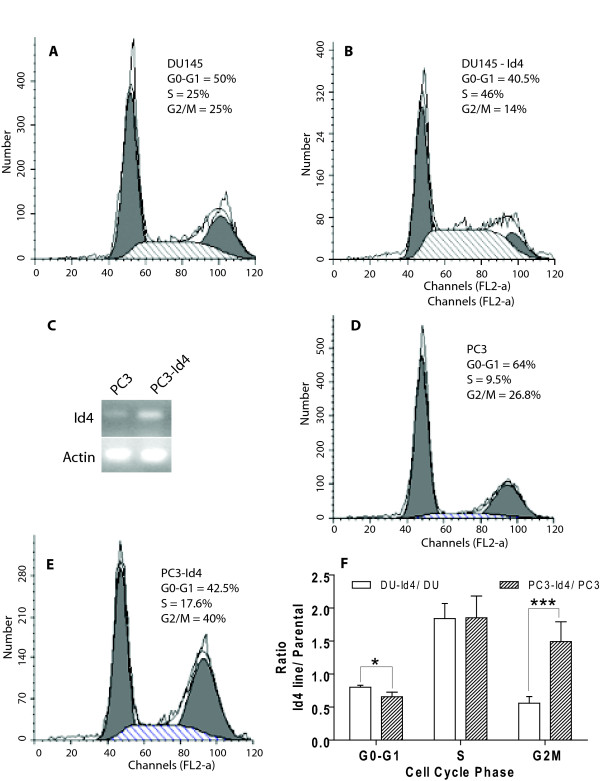
FACS analysis of cell cycle parameters in DU145, DU145-Id4, PC3 and PC3-Id4 cell lines. The cells were serum starved for 24 hours in order to synchronize the cell cycle. The cells were then serum stimulated (10% BCS) in order to determine the effect of Id4 on cell cycle. A and D: Serum treated DU145 and PC3 cells respectively, B and E: Serum treated DU145-Id4 and PC3-Id4 cells respectively. The cell cycle analysis and the fraction of cells in each phase (G0-G1, S and G2/M, indicated as % cells) were determined using ModFit cell cycle analysis software. The data is representative of triplicate experiments. Of note is the number of cells (scale) represented on the Y-axis. C: Reverse Transcriptase polymerase chain reaction demonstrating the expression of Id4 in PC3 (lane 1) and PC3 cells stably transfected with Id4 expression plasmid (Lane 2). Weak Id4 expression was observed in PC3 cells whereas significantly higher expression was observed in PC3-Id4 cells (representative of 3 different PCR reactions). F: The ratio of cells in each phase. The ratio was calculated by dividing the % cells in Id4 expressing cells by parental cells in each phase of cell cycle. This calculation was used to normalize and compare the data between two cell lines. The error bars represent standard error of mean calculated from three different experiments (*: P > 0.05 and ***: P > 0.001).